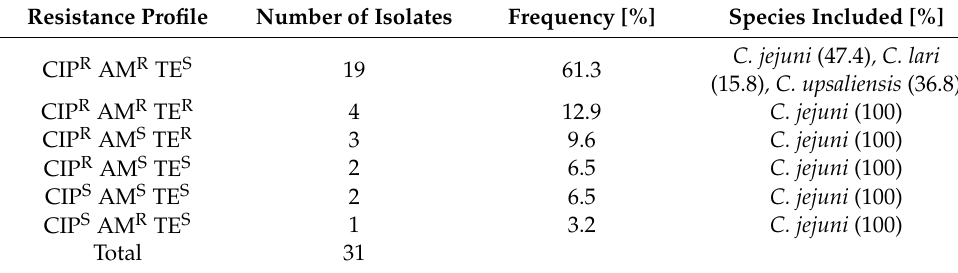
Table 1. Frequency of occurrence of the AMR patterns obtained in this study.